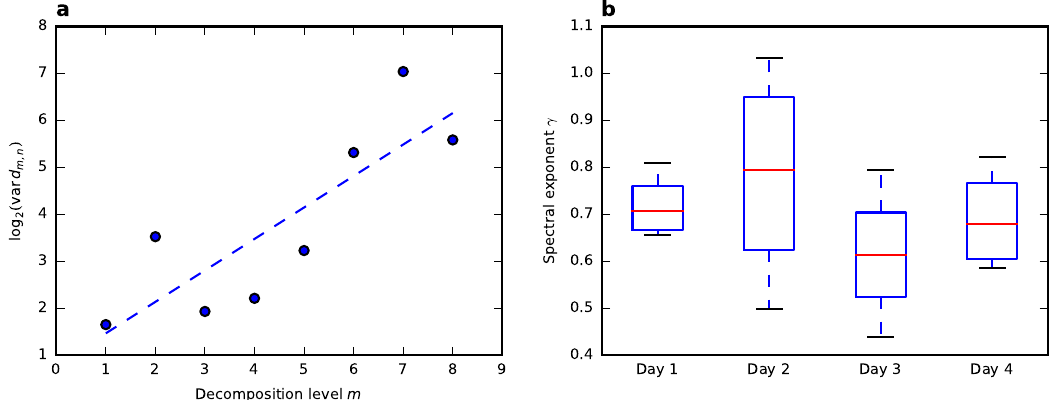
Figure 10. The determination of the spectral exponent γ and its statistical representation. ( a ) Illustrates the distribution of the spectral exponent γ , calculated according to Equation (1), as a function of the decomposition level. The dashed line represents a trend line calculated by the method of least squares. ( b ) Illustrates the minima and maxima of the spectral exponent γ together with the first, second, and third quartiles Q1, Q2, and Q3 that are associated with the four days of the measurement